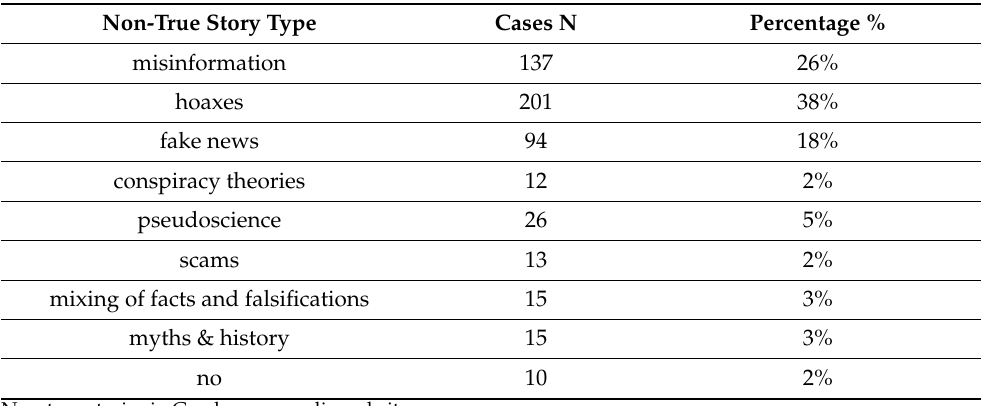
Table 1. Fake news types, cases & percentages.